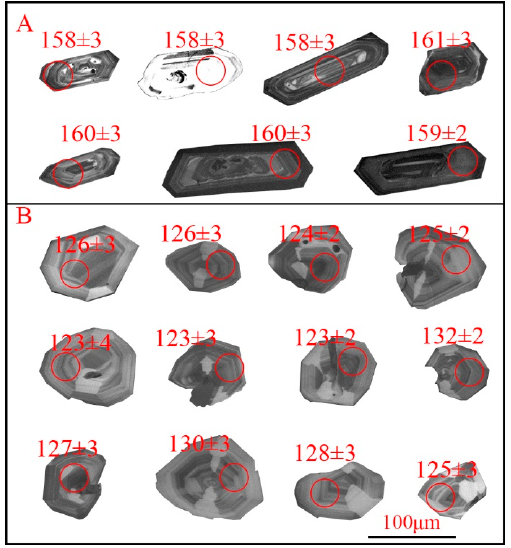
Figure 6. Cathodoluminescence (CL) images and the LA-ICP-MS 206 Pb/ 238 U age of represented zircon grains from the Maoping medium–coarse-grained Fe–Li micas granite ( A ) and the fine-grained Fe–Li micas granite ( B ).